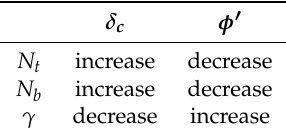
Table 5. Parameters effects on the chemical reaction in the